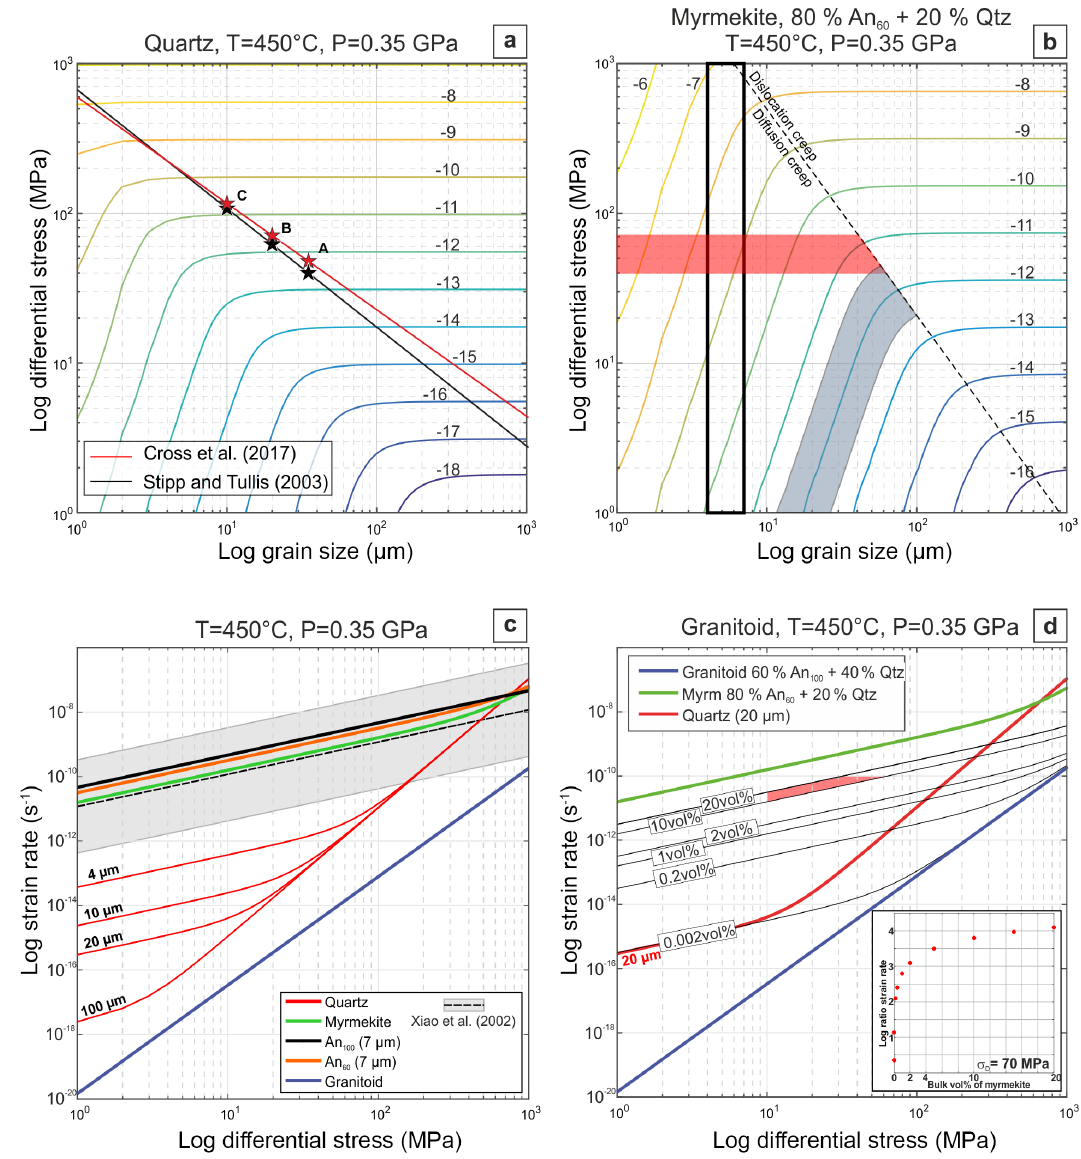
Figure 9. Diagrams derived from the calculation of the rheological model explained in the text. Grain size vs. differential stress map with contoured strain rate curves calculated for (a) Qtz and (b) 80% Plg (An 60 ) + 20% Qtz aggregates. (a) The piezometric curve from Stipp and Tullis (2003, black curve) and Cross et al. (2017, red curve) are reported. Red and black stars mark the differential stress/strain-rate conditions defined by the grain size observed in pure Qtz layers: (a) 35µm; (b) 20µm; (c) 10µm (Ceccato et al., 2017). (b) The black dashed line represents the boundary between dislocation and diffusion creep dominated conditions. The black rectangle represents the grain size range (4–7µm) observed in the sheared myrmekite. The grey semi-transparent polygon defines the field of possible grain-size and differential stress conditions for iso-strain-rate conditions defined from piezometric relations. (c) Log differential stress vs. log strain rate diagram reporting the curve calculated for pure Qtz with different grain sizes (4, 10, 20, 100µm), sheared myrmekite, ideal granitoid rock and the curves representing the rheology of pure feldspar aggregates. For comparison, one of the curve obtained from experimental data of Xiao et al. (2002) is reported (black dashed curve). Grey field represents the uncertainties in the experimentally defined rheological curve. (d) Log differential stress vs. log strain rate diagram reporting the curve calculated for pure Qtz, sheared myrmekite, and ideal granitoid rock and the curves representing the rheology of a granitoid (60% An 100 Plg + 40% Qtz) with a variable amount of sheared myrmekite (80% An 60 Plg + 20% Qtz). Maximum replacement is limited to 20% of initial feldspar (see text for explanation). Transparent red polygon defines the stress-strain rate conditions for 15%vol substitution of myrmekite (see text for explanation). The small figure inset shows the logarithm of the ratio between the strain rate of an ideal granitoid rock vs. that of a granitoid with increasing myrmekite substitution at the differential stress of